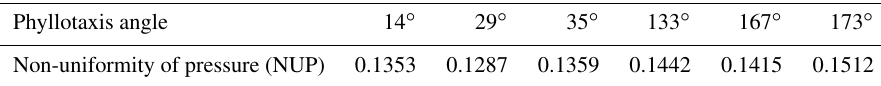
Table 2. Pressure non-uniformity of different FAPs.